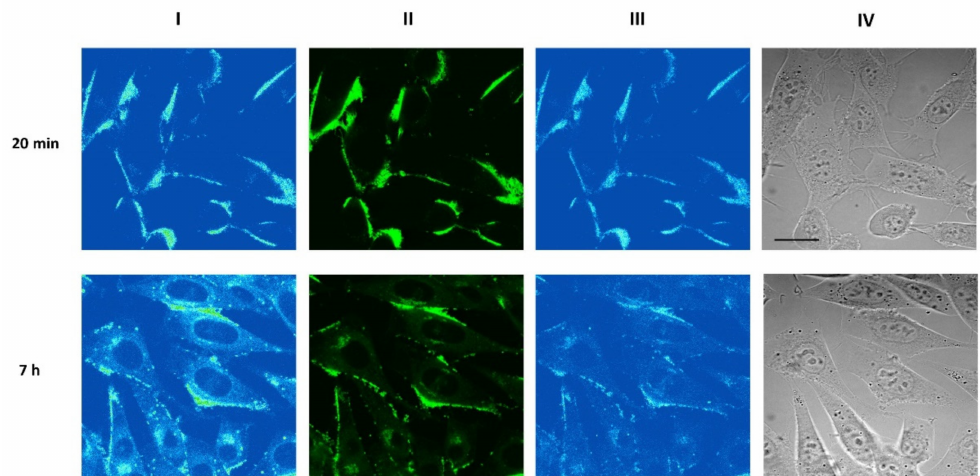
Figure 5. Confocal fluorescent images of S37 cells incubated with 8 µ M BChl–S–S–NI for 20 min (top 325 row) or 7 h (bottom row). (Column I) Distribution of fluorescence excited at 514 nm and registered 326 at >730 nm (Columns II, III). Distribution of fluorescence excited at 458 nm and registered in the 327 570–620 nm range (column II) or at >730 nm (column III). (Column IV) Transmitted light images of cells. Scale bar—20 µ